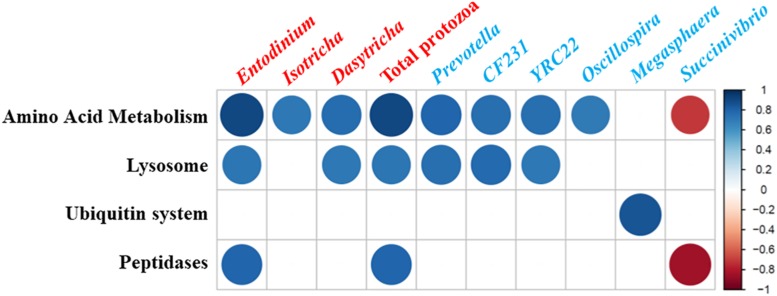
Correlations between microbial taxa [log-transformed counts of protozoal genera (labeled in red) and relative abundances of bacteria (labeled in blue) were used] and relative frequency of CowPI-predicted functional features related to protein metabolisms in the in vitro cultures. Only the strong correlations (Pearson correlation coefficient, |r| > 0.8; P < 0.05) were shown. The size and intensity of the color of each circle indicate the degree of the correlation coefficient based on the color key on the right side.